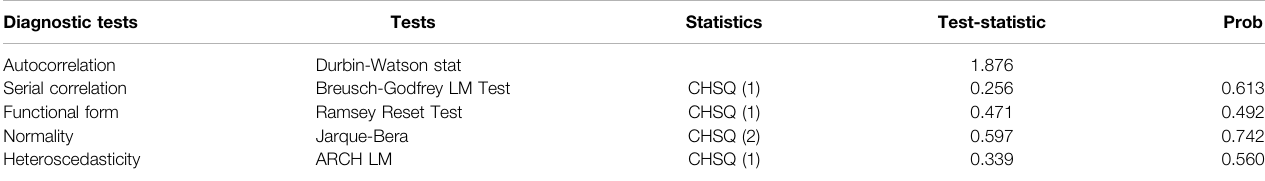
TABLE 6 | Diagnostic tests for the ARDL model.